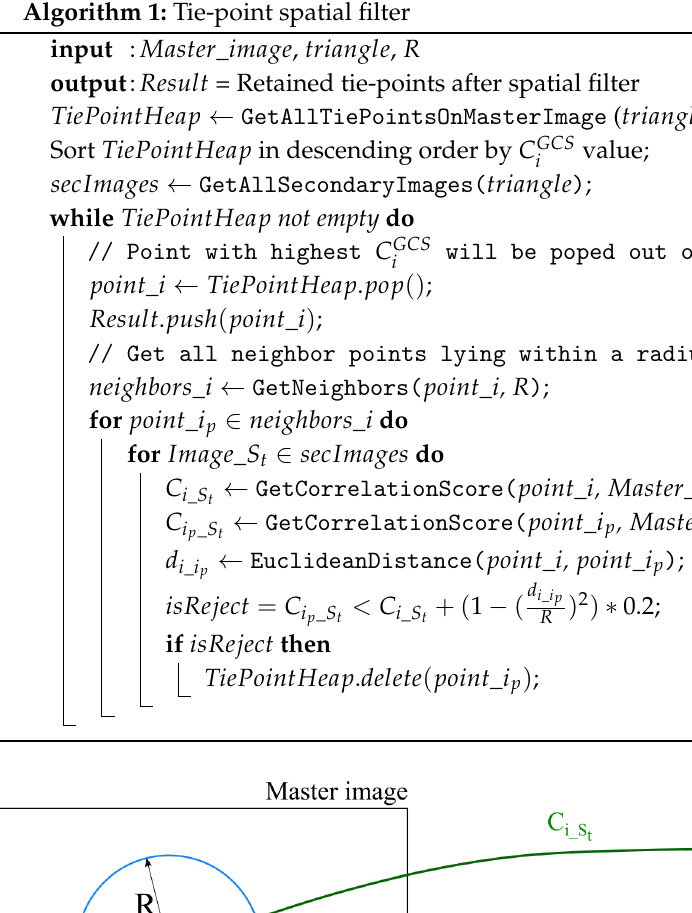
Algorithm 1: Tie-point spatial filter